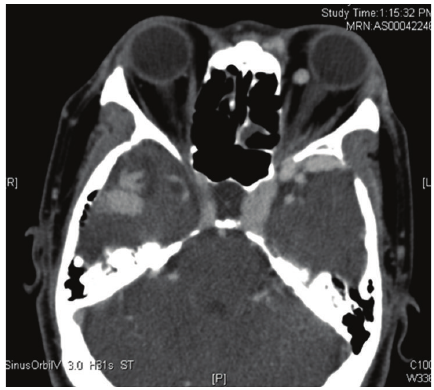
Figure 3: Enlarged cavernous sinuses and dilated left superior ophthalmic